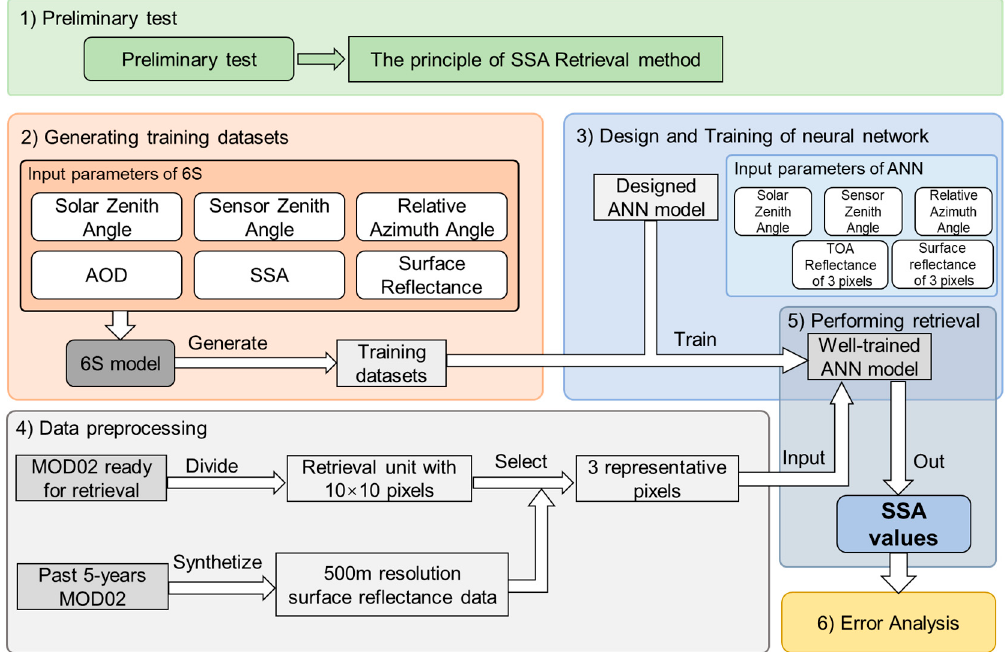
Figure 1. Flow chart of SSA retrieval method.